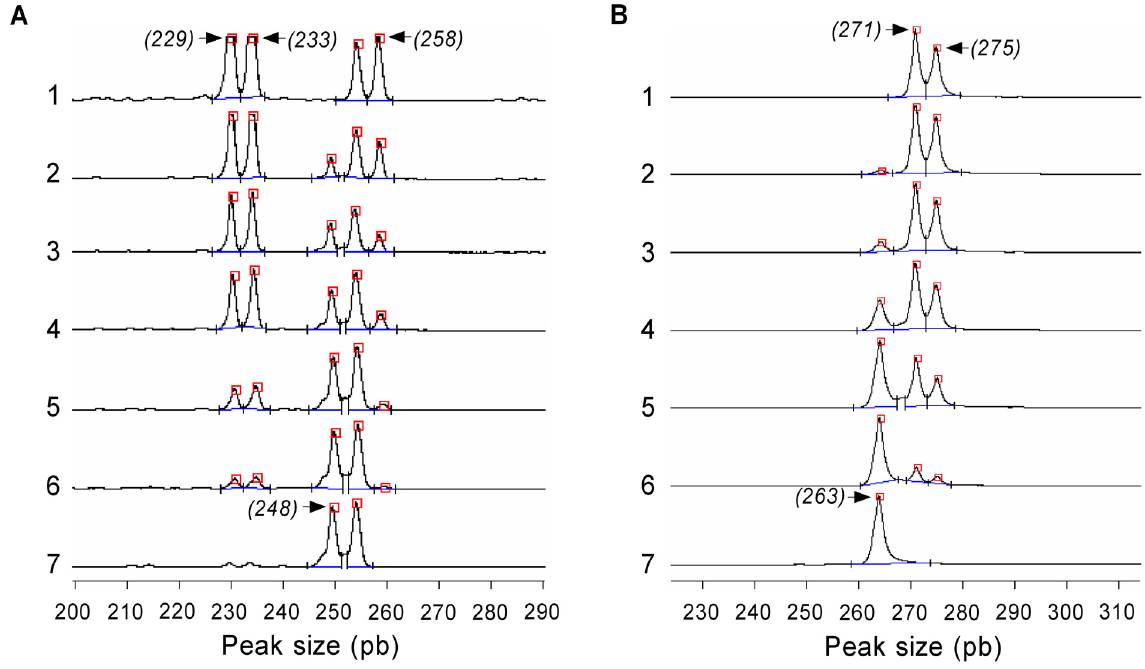
Figure 1. Electrofluorograms obtained by LSSP-PCR and polymorphic microsatellite (locus TcAAAT6 ) analyses of artificial mixtures of DNA from JG and CL Brener. Genomic DNA samples from JG (lane 1) and CL Brener (lane 7) were mixed at different proportions (JG/CL Brener: 9/1 (lane 2), 3/1 (lane 3), 1/1 (lane 4), 1/3 (lane 5) and 1/9 (lane 6)), as illustrated in the figures, and subjected to PCR assays. Fluorescent products of LSSP-PCR (A) and TcAAAT6 (B) were loaded in each lane in a 6% polyacrylamide gel under denaturing conditions in an automatic laser fluorescent (ALF) DNA sequencer. The numbers at the peaks refer to the size of amplicons and arrows indicate specific peaks from JG or CL Brener, which were used to produce the standard